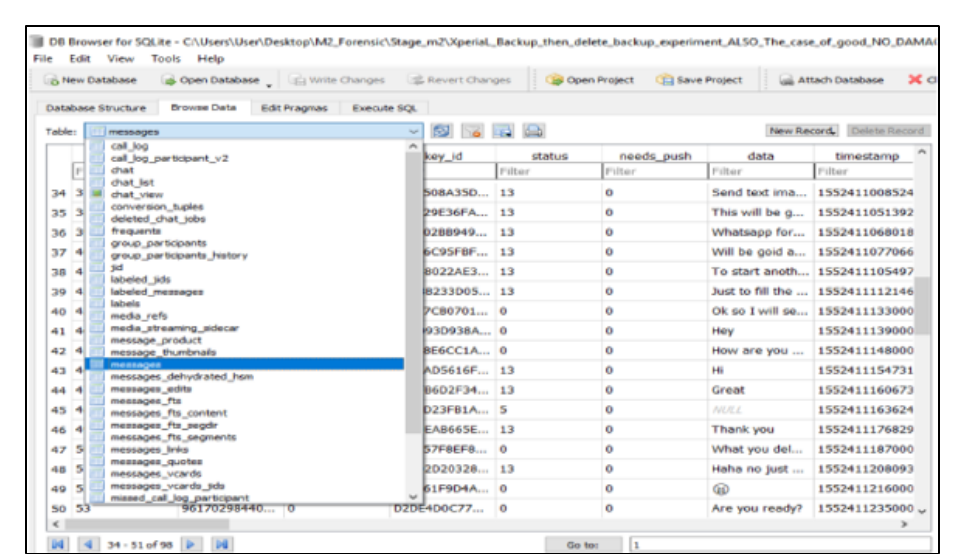
Figure 6. The database is successfully decrypted